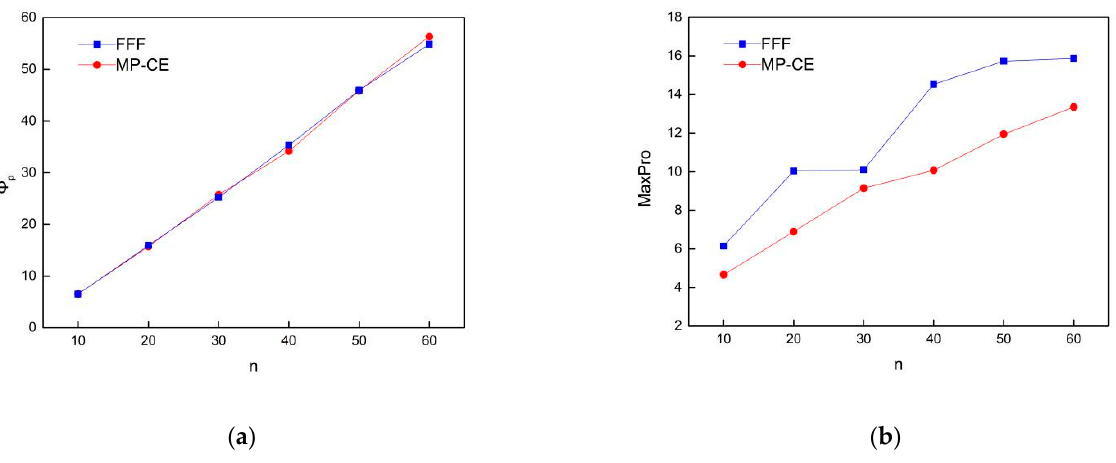
Figure 5. Performance comparison: ( a ) φ p ; ( b )